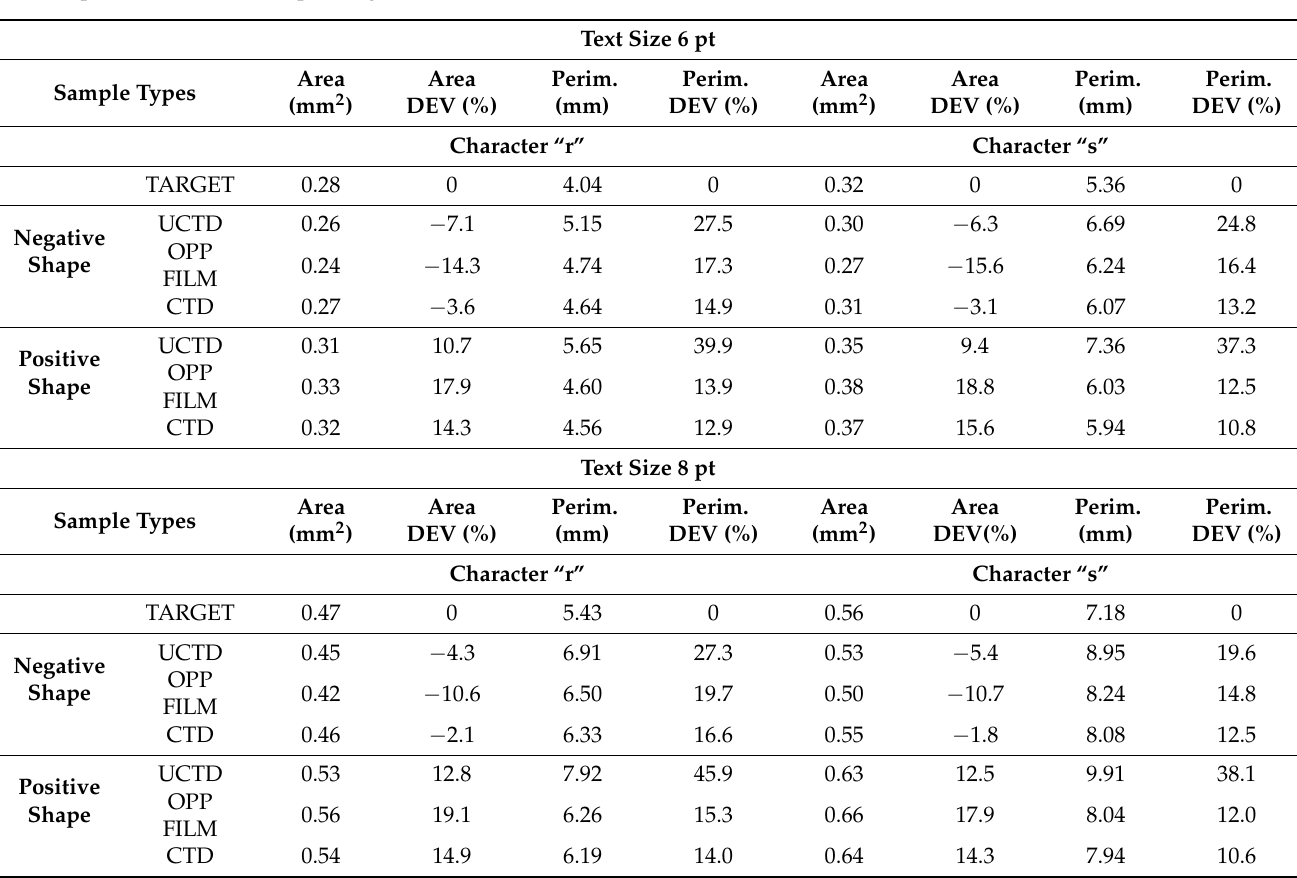
Table 2. Results of measuring of area and perimeter for two text sizes of 6 pt and 8 pt printed in positive and negative shapes on three different printing